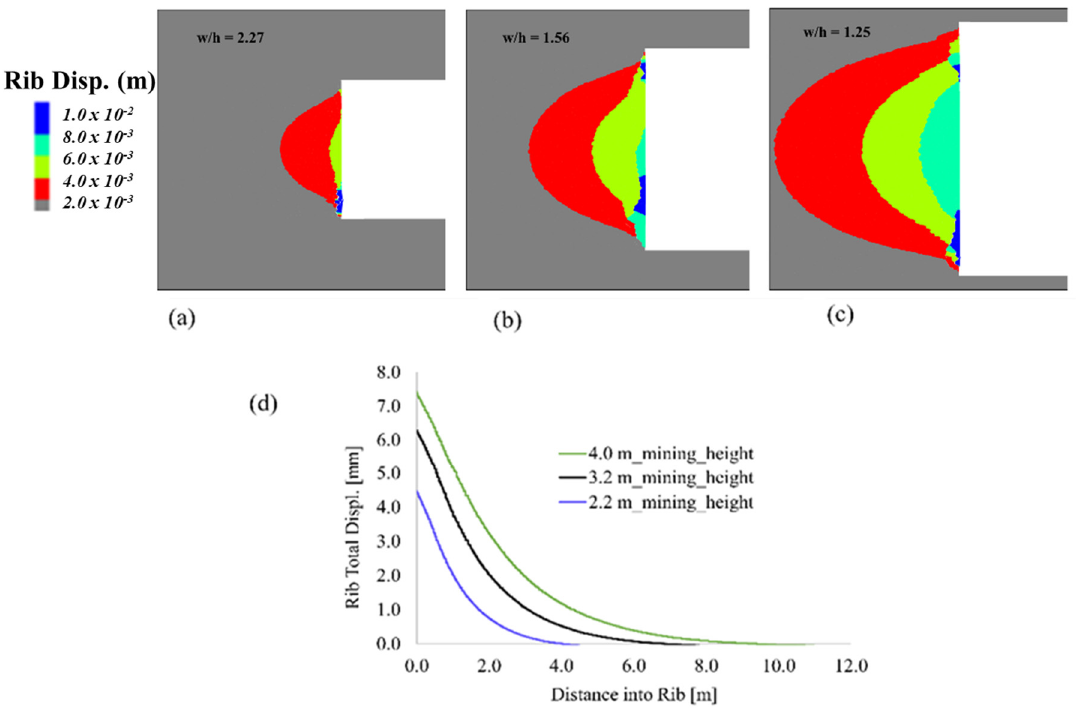
Figure 13. Rib deformation results. ( a ) w/h = 2.27, ( b ) w/h = 1.56, ( c ) w/h = 1.56, and ( d ) the displacement plot in the middle of the rib.